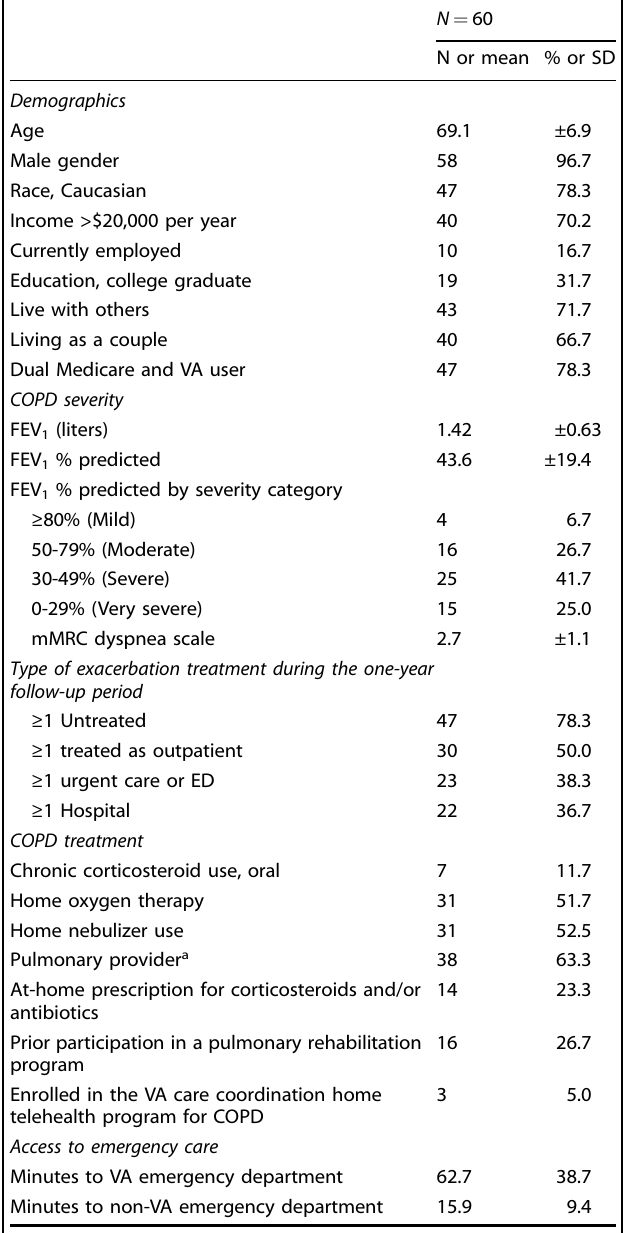
Table 1. Demographics of interviewed